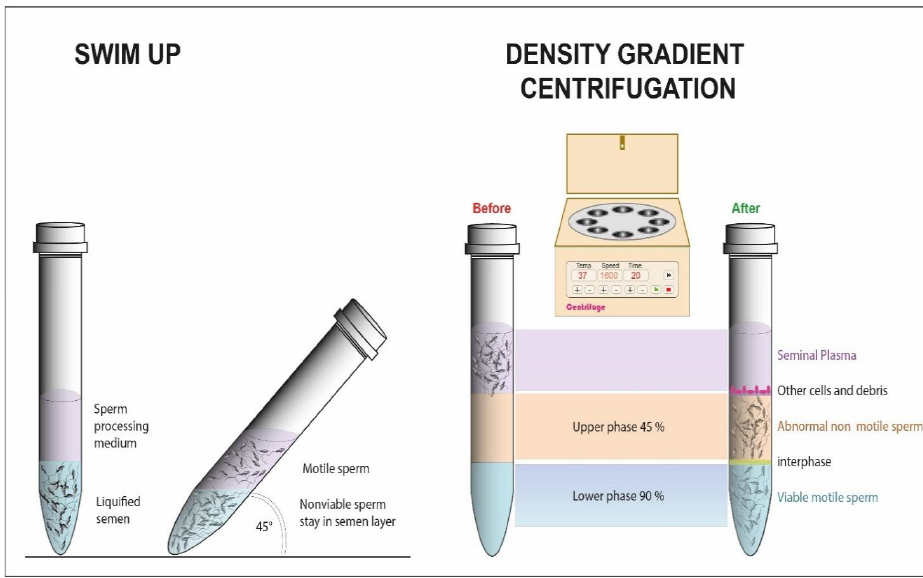
Figure 1. Schematic representation of swim-up and density gradient